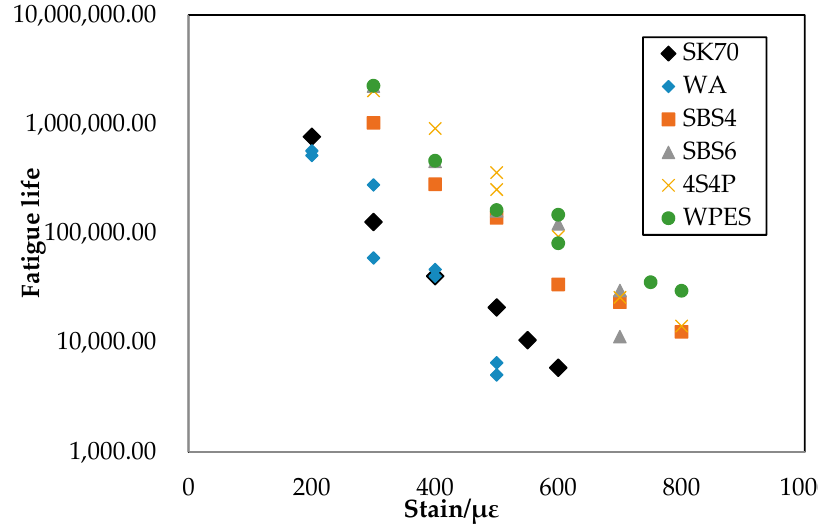
Figure 3. The fatigue life of different asphalt mixtures of 4PB at varied strain levels.